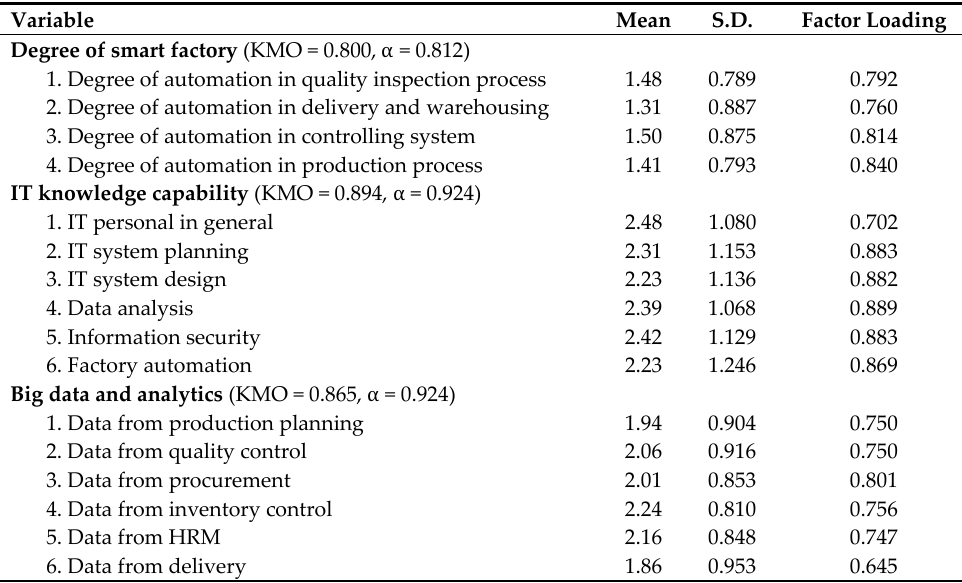
Table 1. Reliability test and factor analysis.